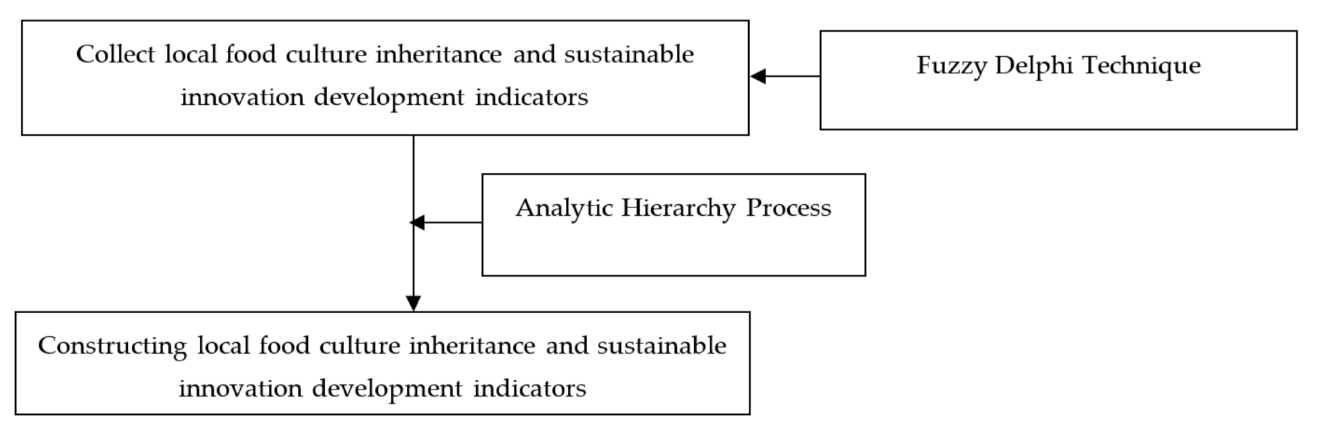
Figure 2. Research flowchart of agricultural indicator prioritization by experts in